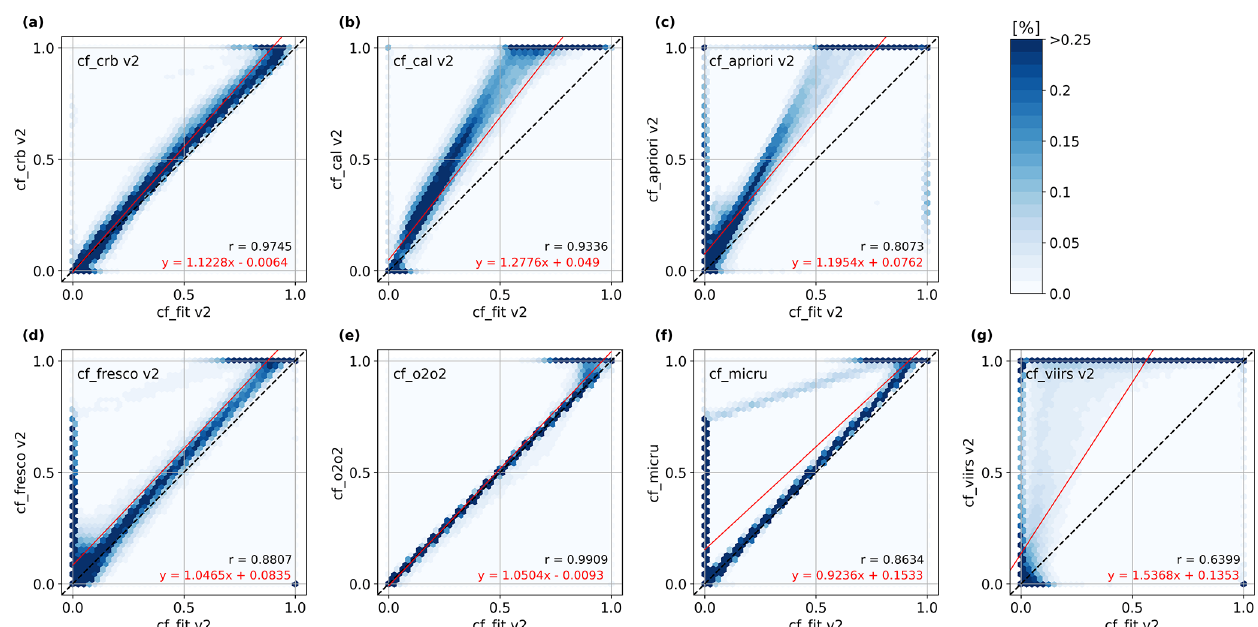
Figure 7. Density histograms between the version 2 cloud fractions from (a) ROCINN CRB, (b) ROCINN CAL, (c) OCRA a priori, (d) FRESCO, (e) O 2 –O 2 , (f) MICRU, and (g) VIIRS and the cloud fraction from the NO 2 fitting window (cf_fit) for Europe and the spring day (4 April